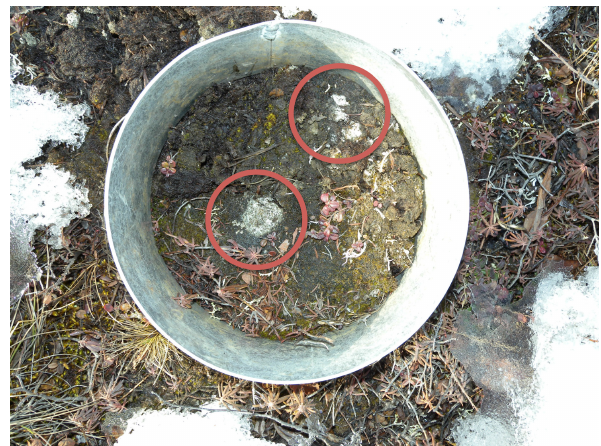
Figure 5. The unidentified fungi colonies (red circles) within the chamber base found on the cryoturbed soils of the UT site on 18 April